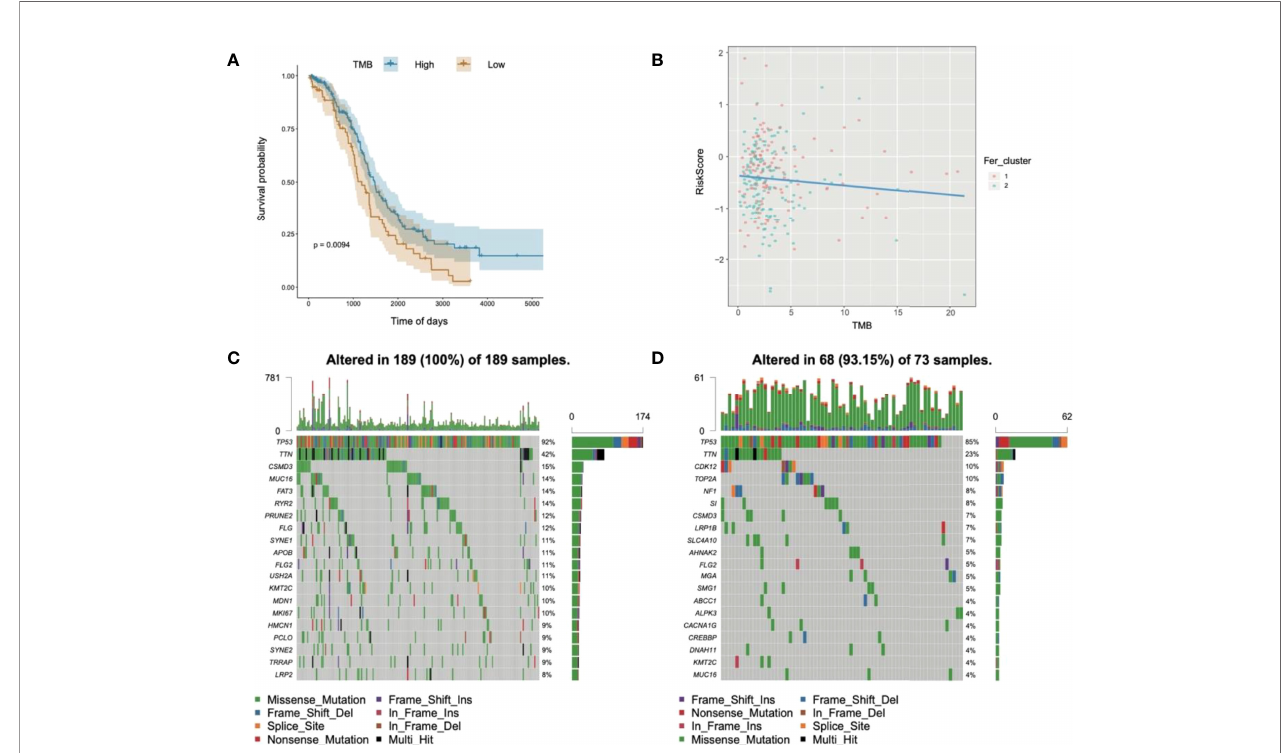
FIGURE 10 | Relationships of risk score and tumor mutational burden for OC. (A) Survival curves of high- and low-TMB groups; (B) correlation analysis in two groups; (C) waterfall chart of gene mutation in the high-risk score group; (D) waterfall chart of gene mutation in the low-risk score